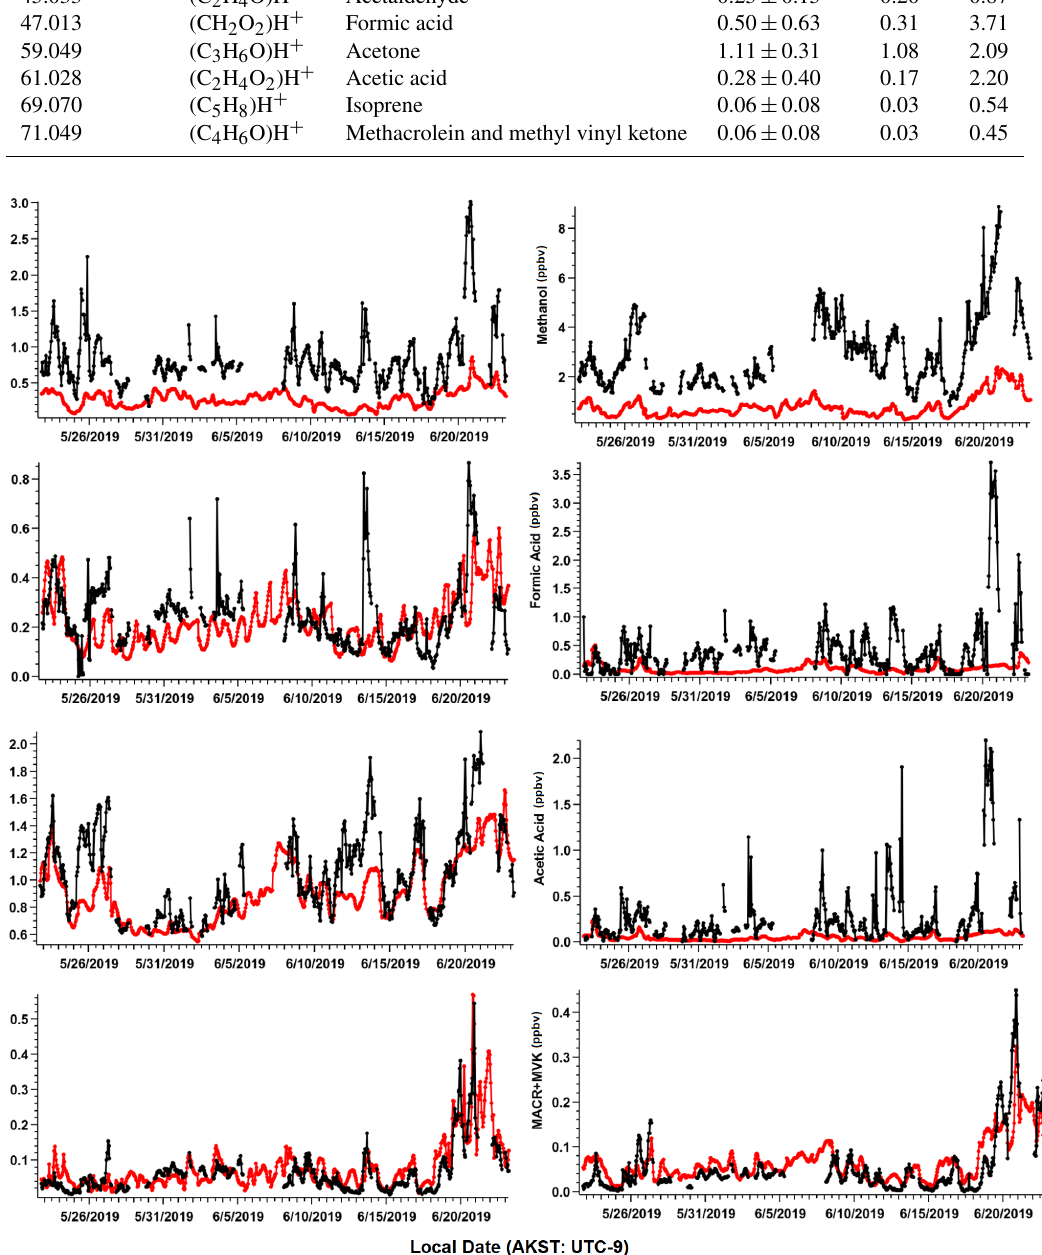
Figure 3. Ambient VOC mixing ratios (ppbv) as observed (black) and simulated by GEOS-Chem + MEGANv2.1 (red). Observations shown are hourly averages computed from 2min measurements and have been filtered for local pollution and stagnant air (see text).